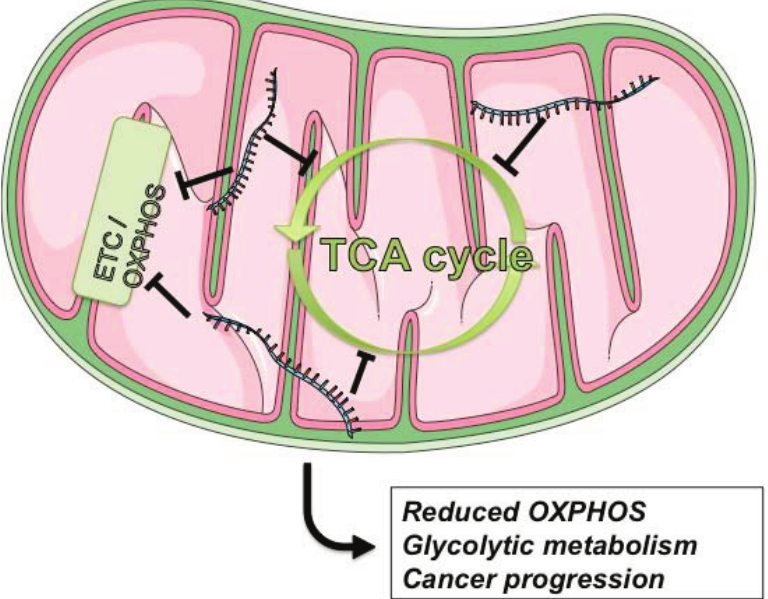
Figure 3. The action of oncogenic miRNAs in mitochondria. By targeting components involved in ETC/oxidative phosphorylation (OXPHOS) and in TCA cycle, miRNAs induce mitochondrial metabolic alterations and a shift from oxidative to glycolytic metabolism, ultimately contributing to Warburg effect and cancer